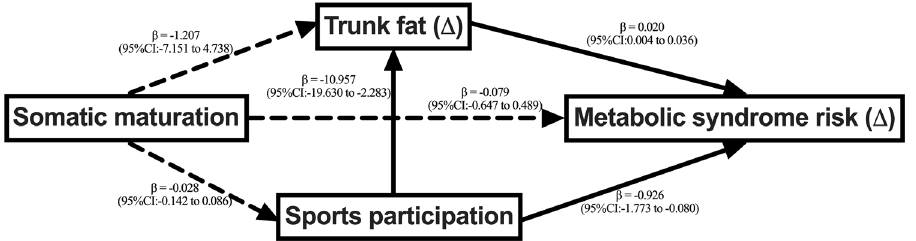
Figure 2. Structural equation model of the association between somatic maturation and metabolic syndrome risk considering trunk fat and sports practice as mediators. Note. Model adjusted for sex, stature, chronological